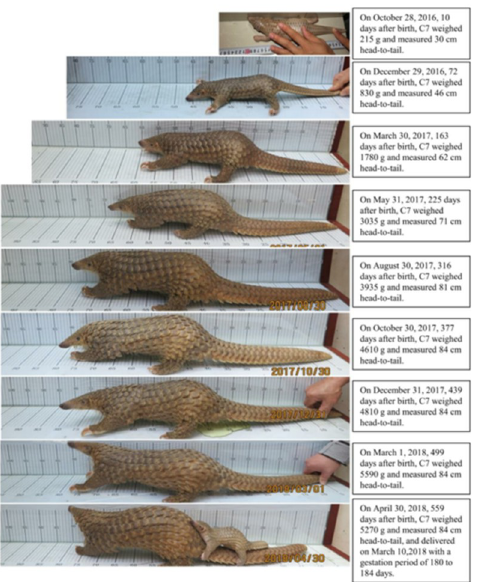
Fig 5. The growth process of the first-generation offspring C7. (Photos: Dingyu